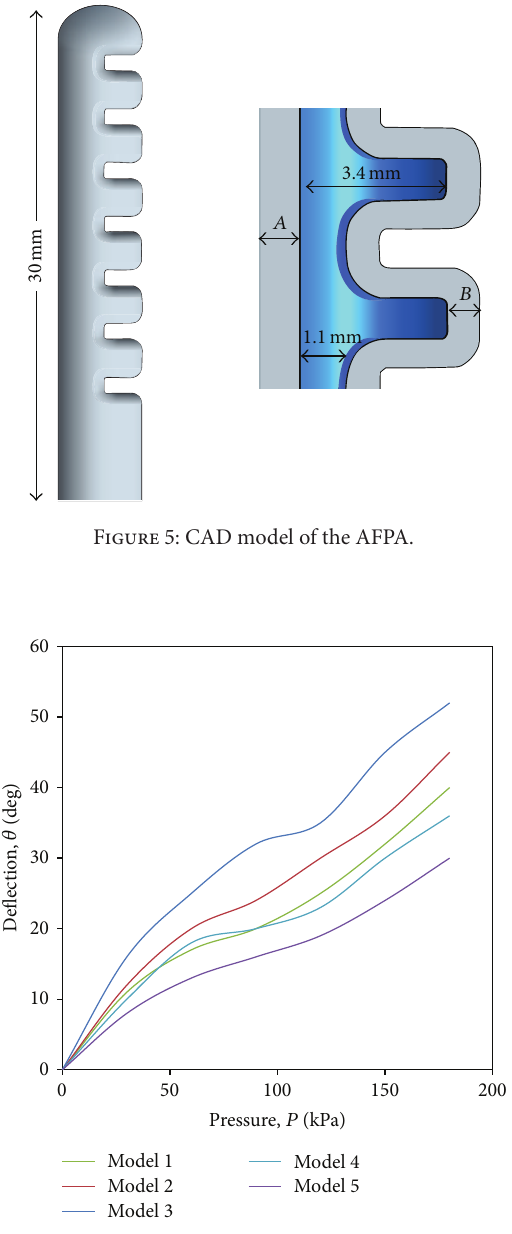
Figure 6: Deflection of AFPA for various models.